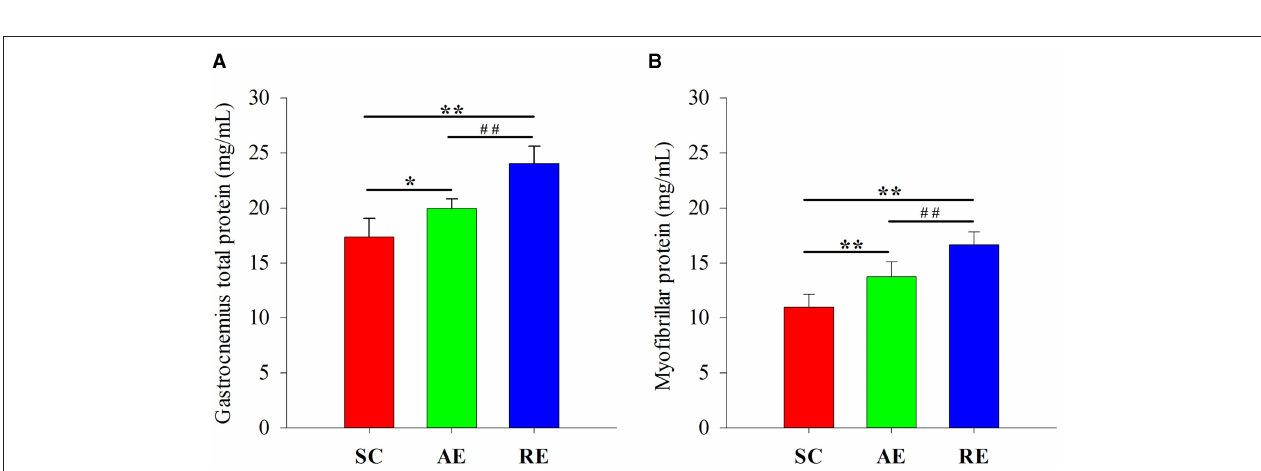
FIGURE 2 | Effects of exercise on (A) total and (B) myofibrillar protein concentration in gastrocnemius muscle. Values are provided as mean ± standard deviation for each group. SC, sedentary control group; AE, aerobic exercise training group; RE, resistance training exercise group. * P < 0.05 vs. the SC group; ** P < 0.01 vs. the SC group; ## P < 0.01 vs. the AE